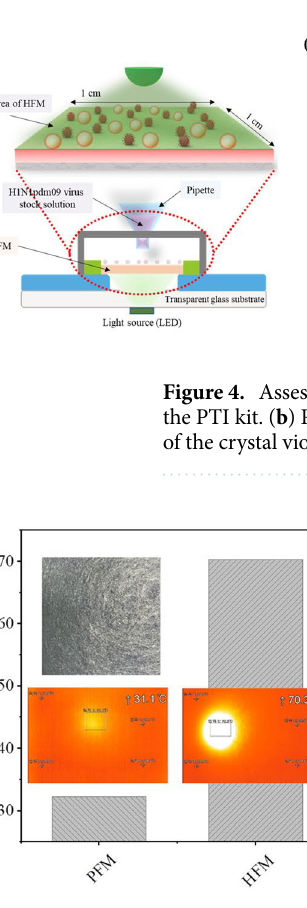
Figure 5. Test for photothermal inactivation of the SARS-CoV-2 virus using the s-HFM. ( a ) Surface temperature of the s-HFM under visible light illumination (100 mW/cm 2 ), ( b ) Result of the TCID 50 assay, and ( c ) Photograph of the crystal violet staining of the MDCK cells with and without